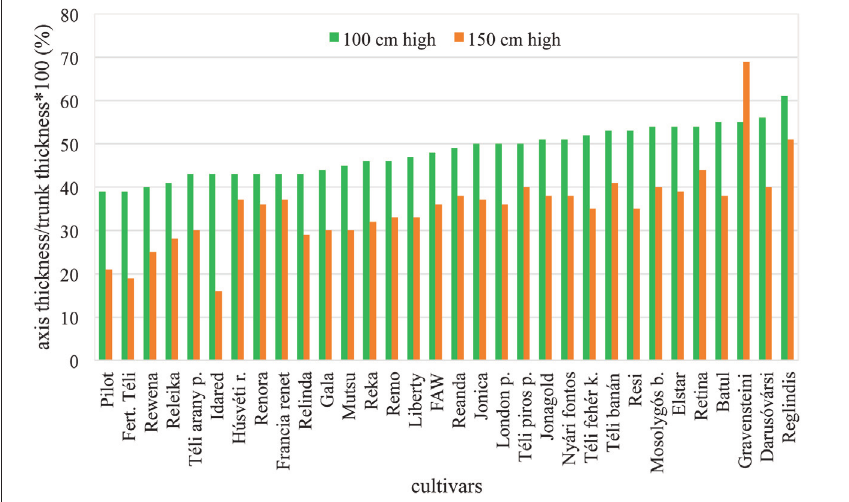
Figure 2. Ratio of the central axis and trunk thickness of 14 years old apple trees in organic production system (Debrecen – Pallag,